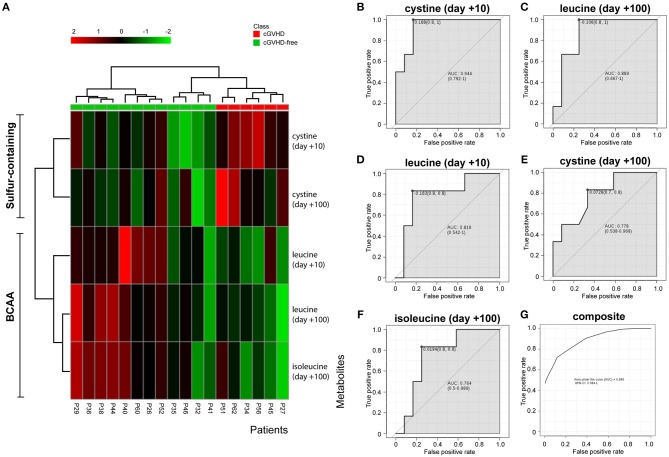
BCAA and cystine cluster cGVHD patients from patients without cGVHD. Clustering analyses and biomarker potential of 3 metabolites in 2 data points in the discovery cohort. (A) Heatmap generated by cystine and leucine auto-scaled concentrations at day +10 and day +100 and isoleucine at day +100. (B–F) Individual receiver operating characteristic (ROC) curves of metabolites and (G) composite ROC curve of the metabolite panel.